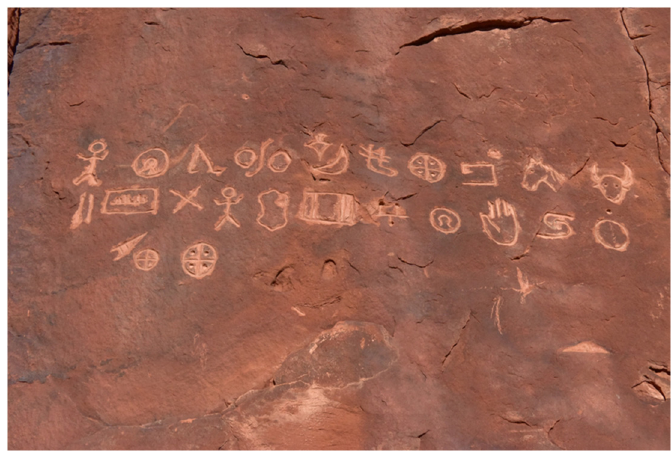
Figure 7. St. George UT WMP panel no. 1.